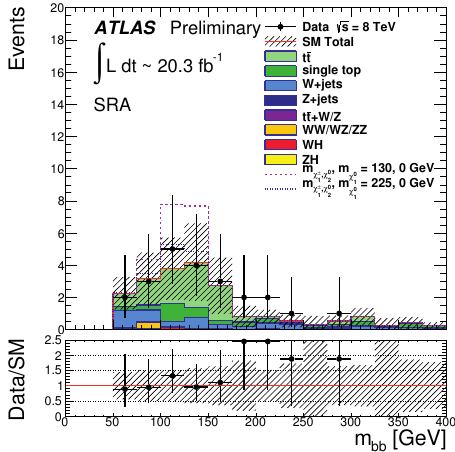
Figure 15: Distribution of m bb for region SRB, sensitive to high ˜ χ